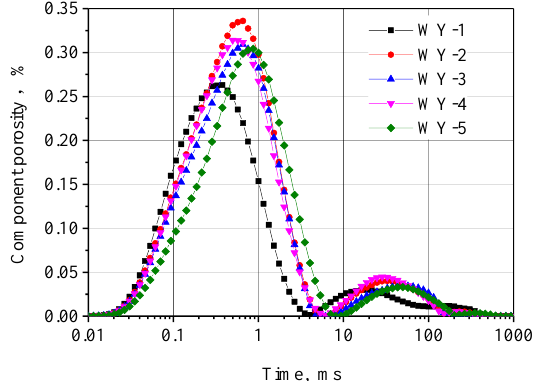
Figure 1. T 2 map of 5 shale samples.